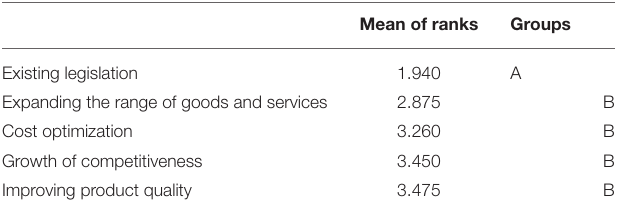
TABLE 2 | Factors influencing the motivation to innovate.